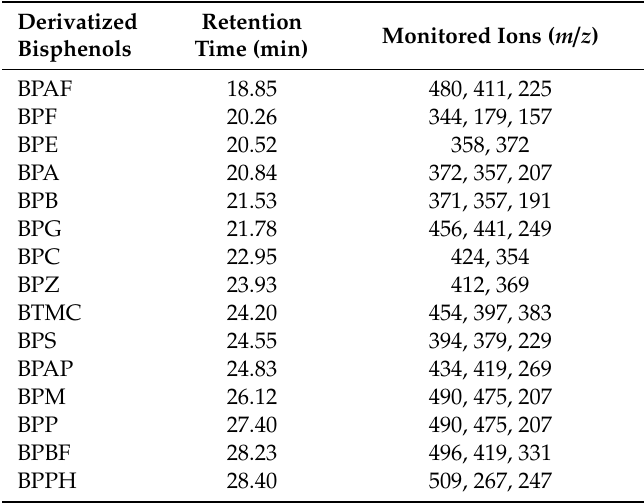
Table 2. List of target analytes with gas chromatography-mass spectrometry (GC-MS) parameters used for